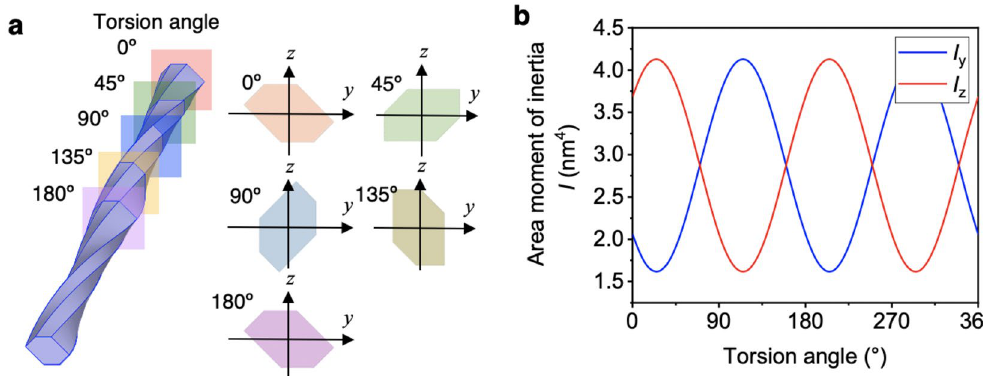
Figure 5. Area moment of inertia periodically modulated by a contour twist. ( a ) Sectional change in the relative torsion angle. ( b ) Area moment of inertia relative to the y and z axes ( I y and I z , respectively), showing a periodic change with respect to the torsion angle. The twisted model figures were exported by COMSOL Multiphysics 5.4 (https ://www.comso